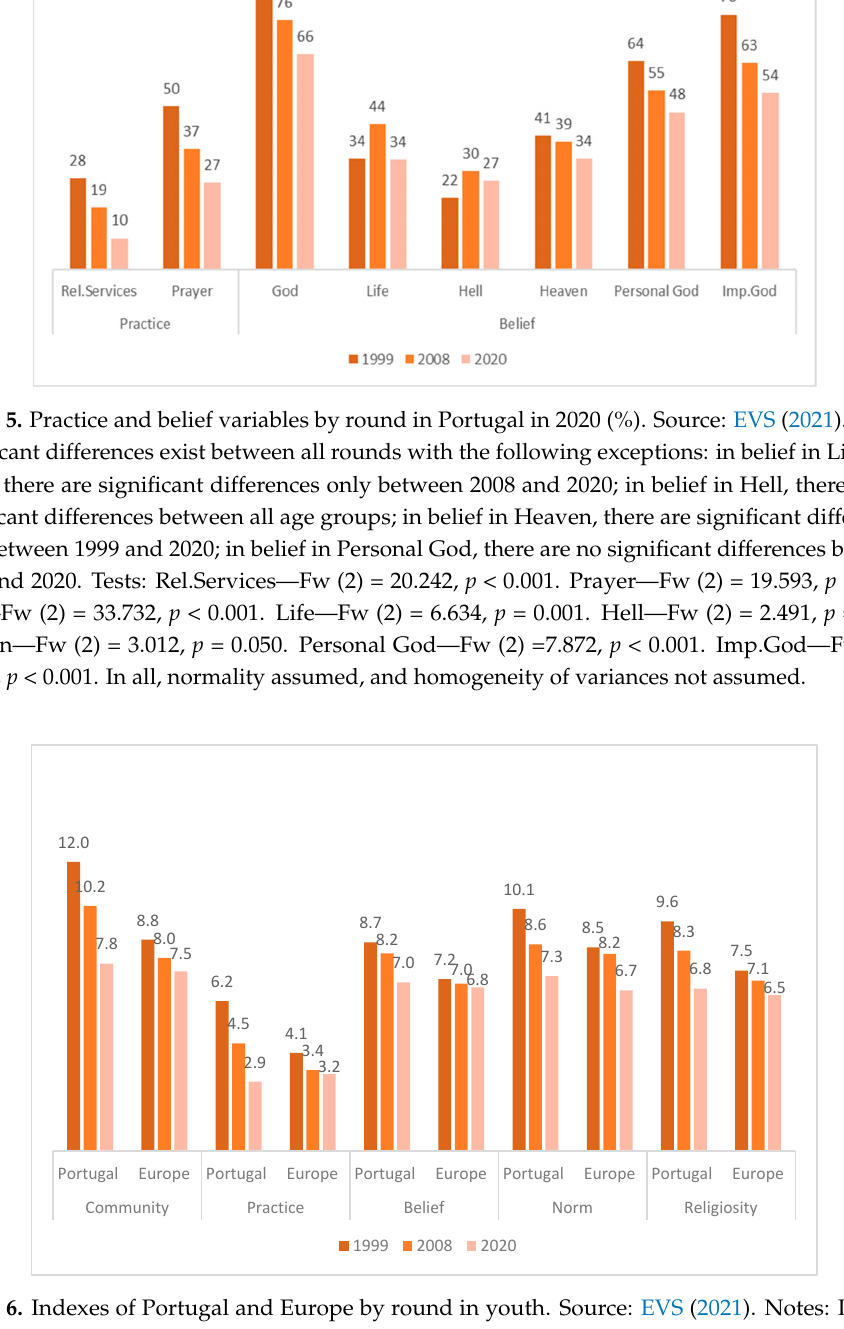
Figure 4. Community and norm variables by round in Portugal in 2020 (%). Source: EVS (2021) . Notes: Significant differences exist between all rounds with the following exceptions: in Importance of religion and justification of Abortion there are no significant differences between 2008 and 2020; in justification of Divorce there are no significant differences between 1999 and 2008. Tests: Imp.Religion—Fw (2) = 17.408, p < 0.001. Rel.Den.—Fw (2) = 32.294, p < 0.001. Self.Religious—Fw (2) = 39.133, p < 0.001. Conf.Church—Fw (2) = 31.276, p <0.001. Homo—Fw (2) = 24.654, p < 0.001.